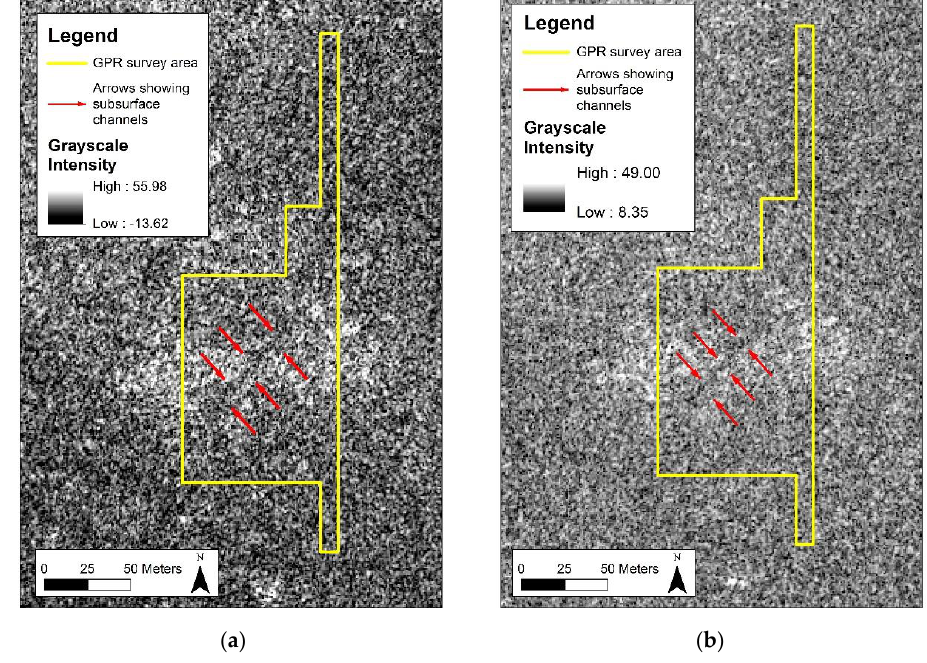
Figure 5. TanDEM-X bistatic grayscale intensity images (dB) with black representing low intensity values and white representing high intensity values. ( a ) 23 July 2017 VV image. ( b ) 25 August 2017 HH image.